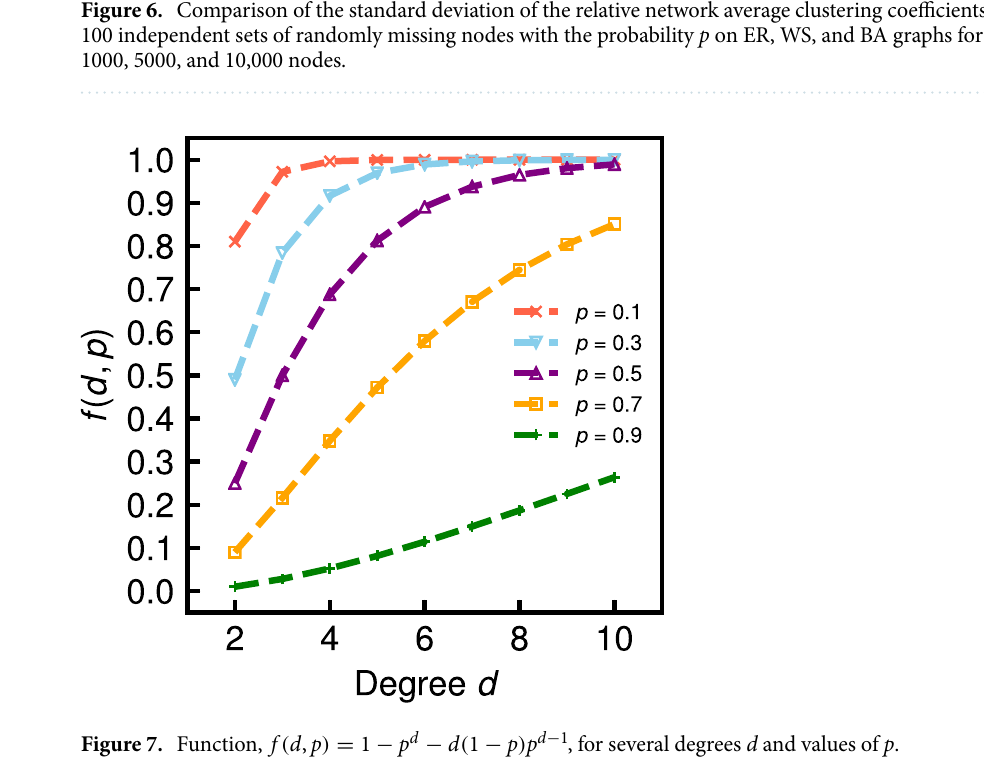
Figure 7. Function, f ( d , p ) = 1 − p d − d ( 1 − p ) p d − 1 , for several degrees d and values of p